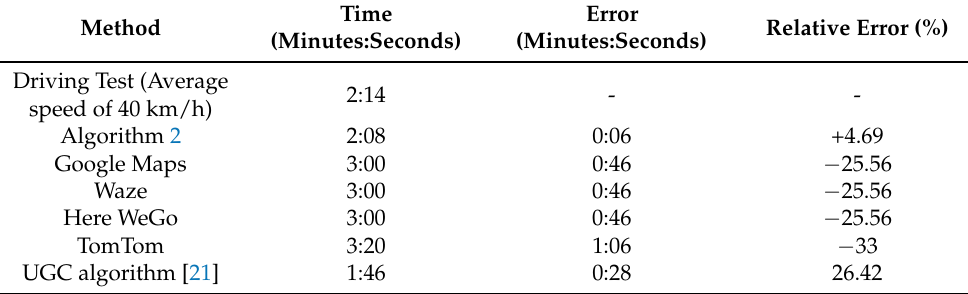
Table 1. Estimation and Error Travel Time along the USM